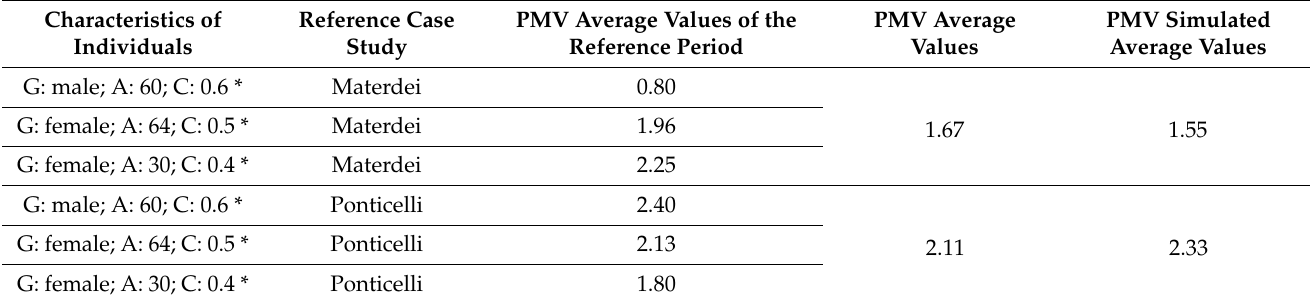
Table 7. Comparison of indoor data extracted from the questionnaire and simulations. Characteristics